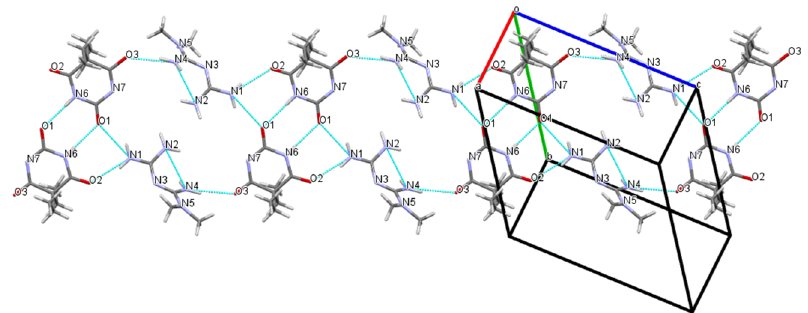
Figure 5 . One-dimensional layered structure connected by hydrogen bonds of Met–Bar. Figure 5. One-dimensional layered structure connected by hydrogen bonds of Met–Bar.